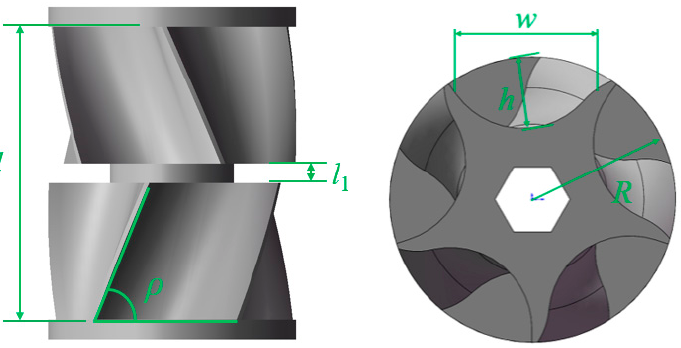
Figure 4. Structure diagram of staggered symmetrical spiral grooved seed feeding wheel. To ensure the applicability of the grooved wheel, a particle with poor flowability and irregular shape and size (e.g., maize seed) was chosen for seeding performance research. Defining relevant design parameters requires a measure of the seed size. Based on shape, maize seeds are roughly divided into four types: large flat, small flat, class large circle, and class small circle. The triaxial dimensions of maize seeds were measured and the average values were calculated. The average length is 11.13 mm, the average width is 8.71 mm, and the average thickness is 5.70 mm